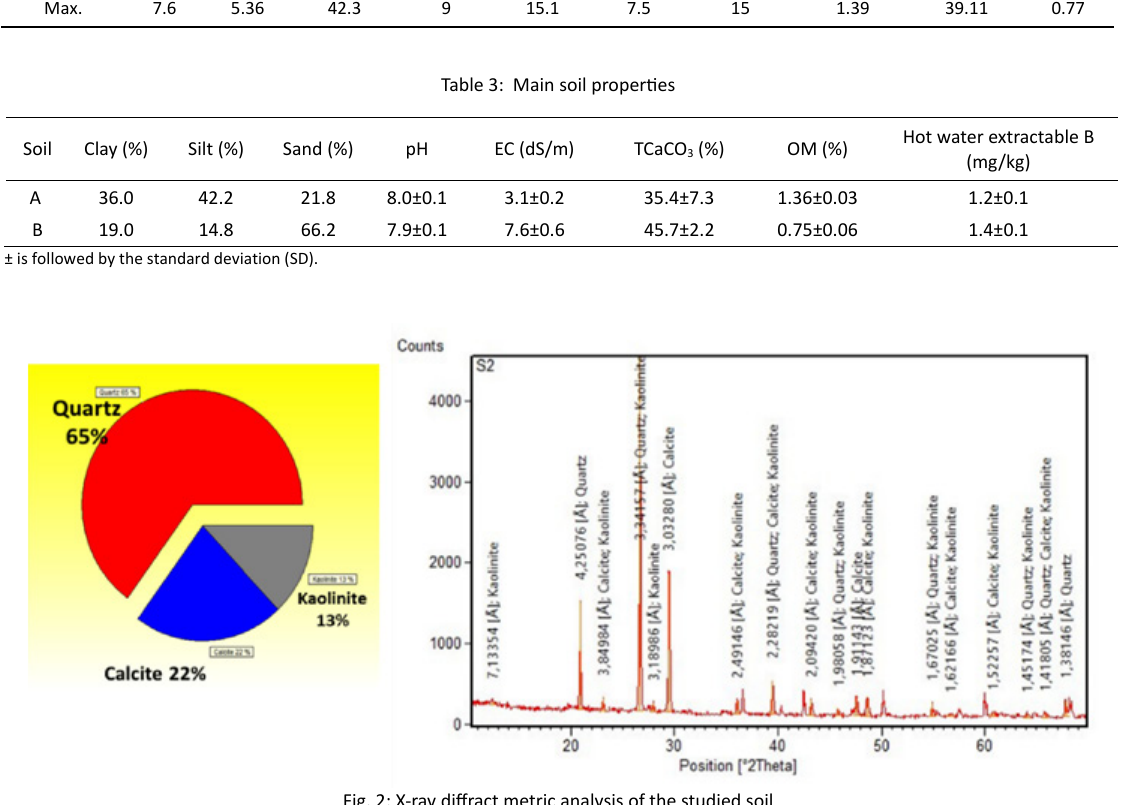
Fig. 2: X-ray diffract metric analysis of the studied Fig. 2: X‐ray diffract metric analysis of the studied soil